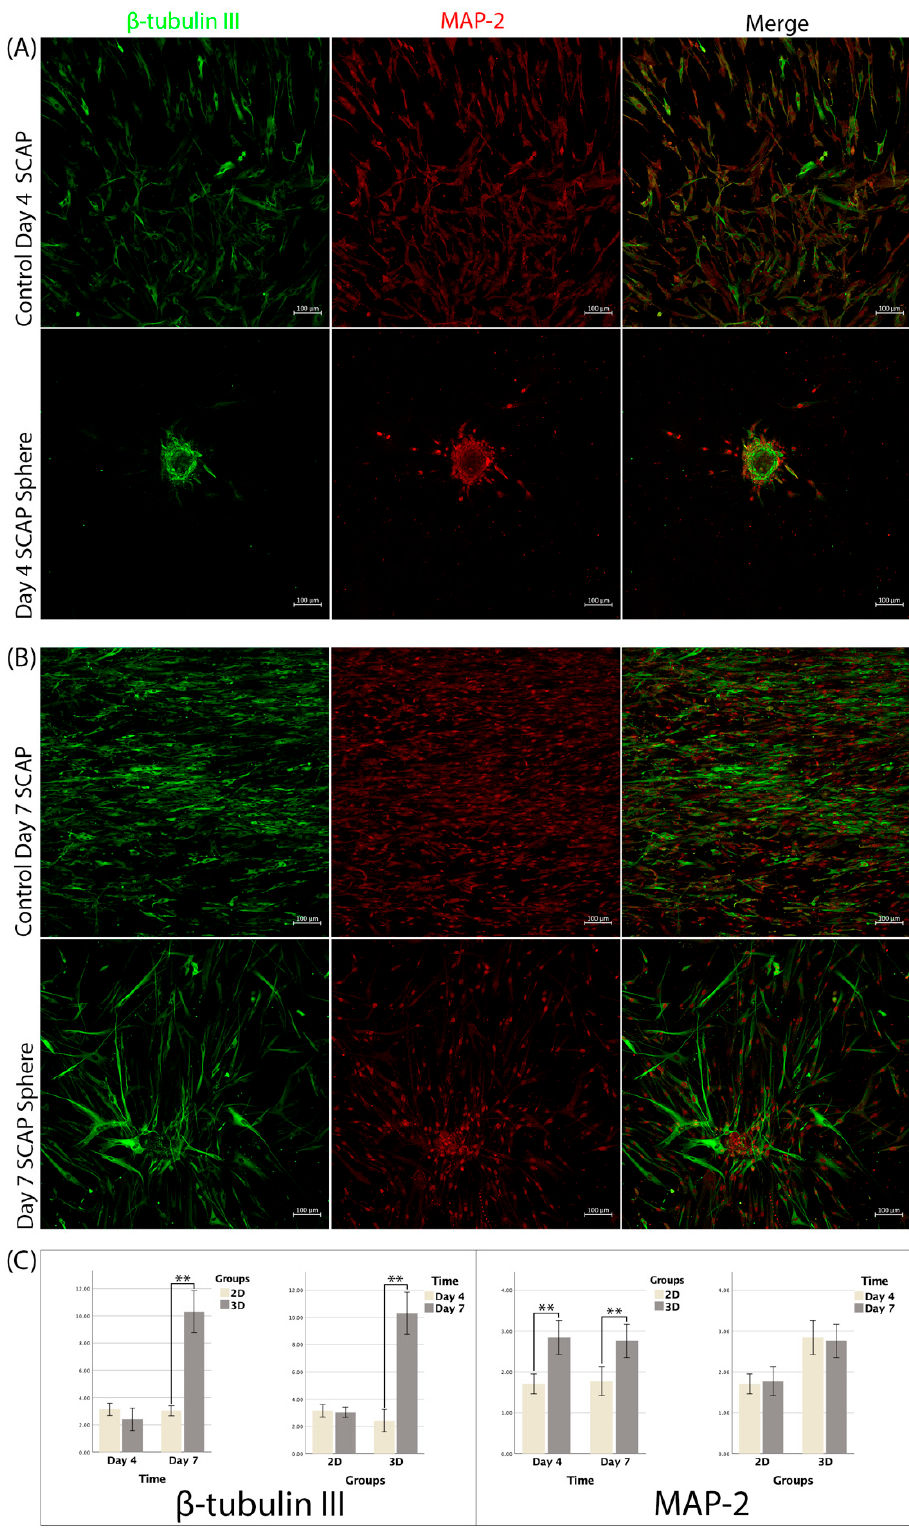
Figure 5. ( A , B ) Immunofluorescence staining for 3D SCAP spheres and 2D SCAPs for detecting β III and MAP-2 expression in different time points; ( C ) Neural markers expression analysis of 2D and 3D SCAPs in two time points, n = 12 (**: p < 0.001).